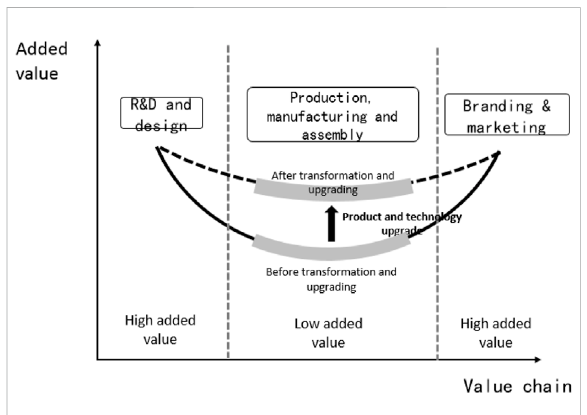
FIGURE 5 Transformation and upgrading path of Shennan Circuits based on the smiling curve.